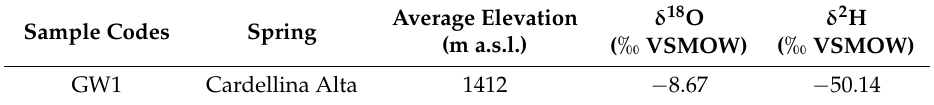
Table 5. Arithmetic Average Method—Average elevation of Cardellina Alta Spring (GW1).